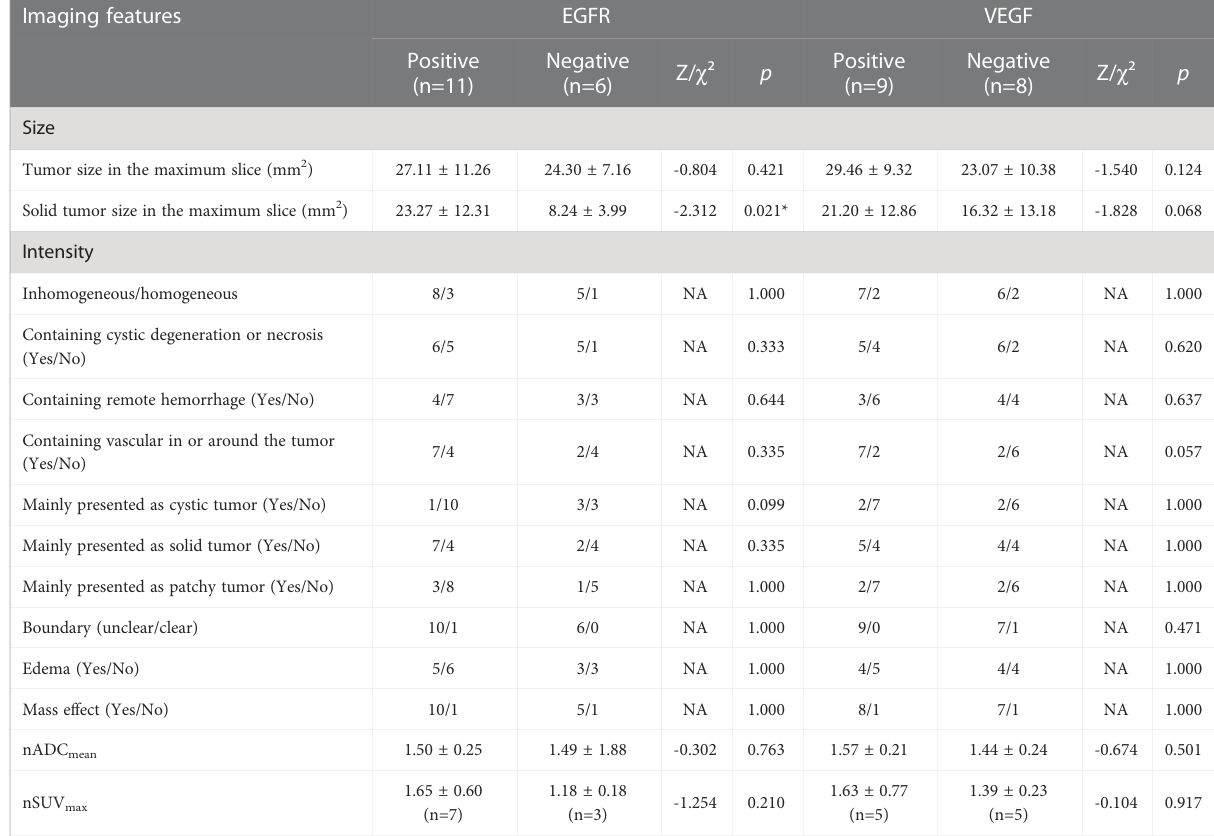
TABLE 3 Association of imaging features with levels of EGFR and VEGF expression. Imaging